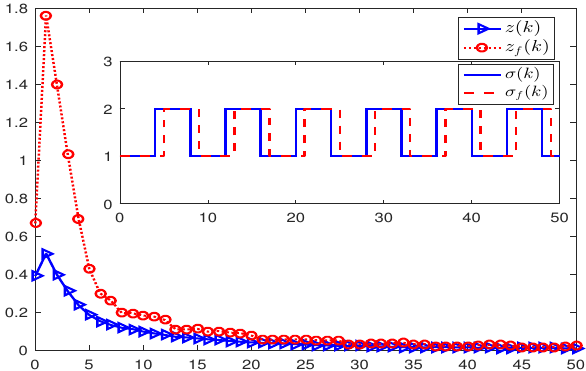
Figure 5. The simulations of z ( k ) and z f ( k ) with an asynchronous switching signal.